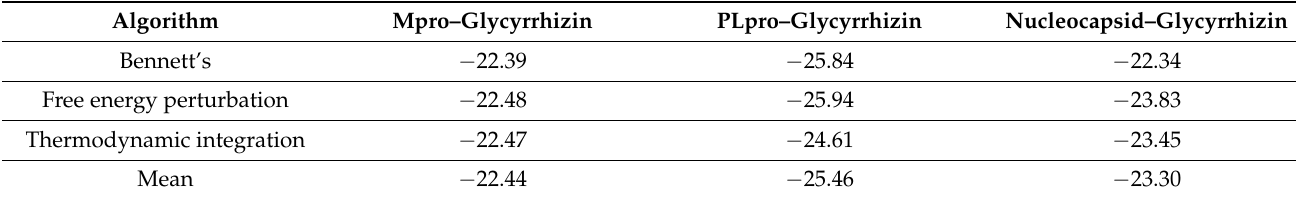
Table 3. WaterSwap absolute binding energy estimation for all four